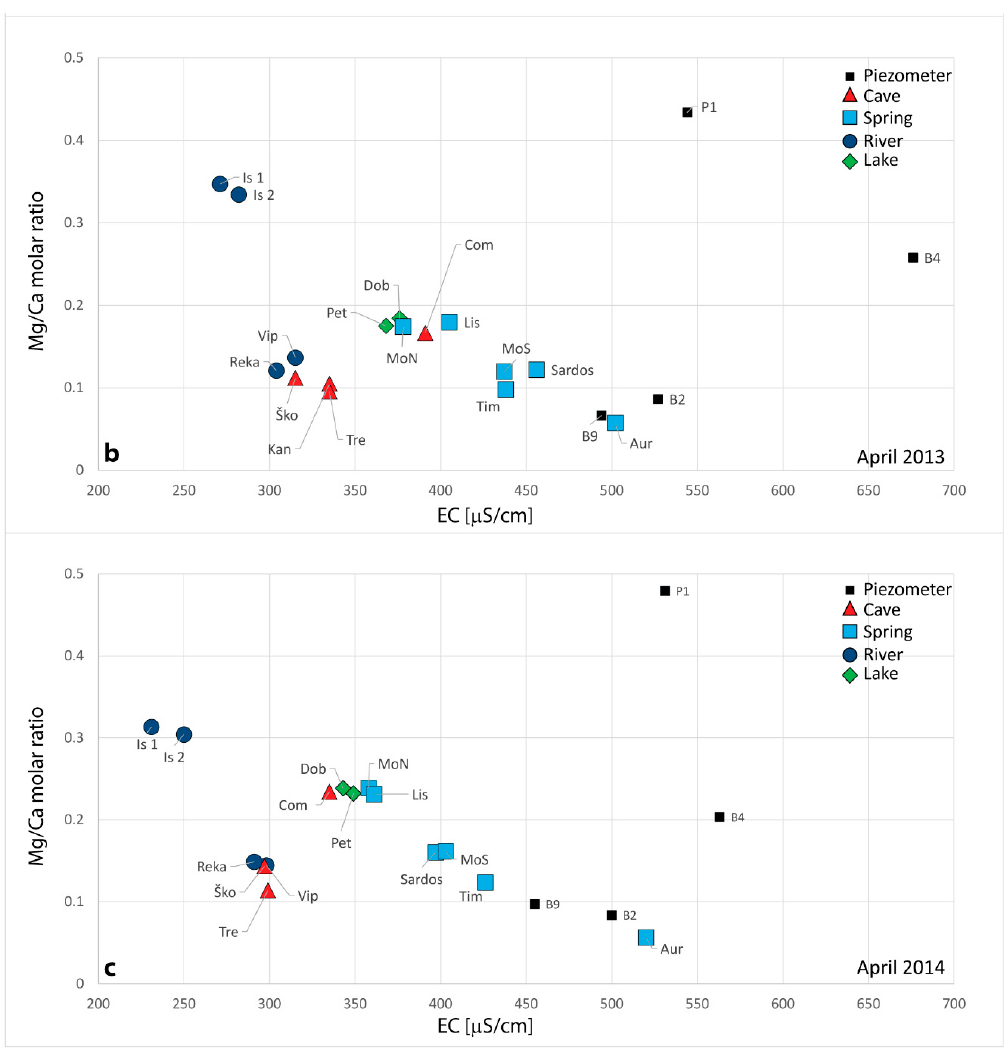
Figure 3. Electrical Conductivity (EC) ( μ S/cm) versus Mg 2+ /Ca 2+ molar ratio. The figure represents three specific hydrogeological conditions: ( a ) extreme low flow; ( b ) decreasing limb of a high flood; ( c ) decreasing limb of a moderate flood.